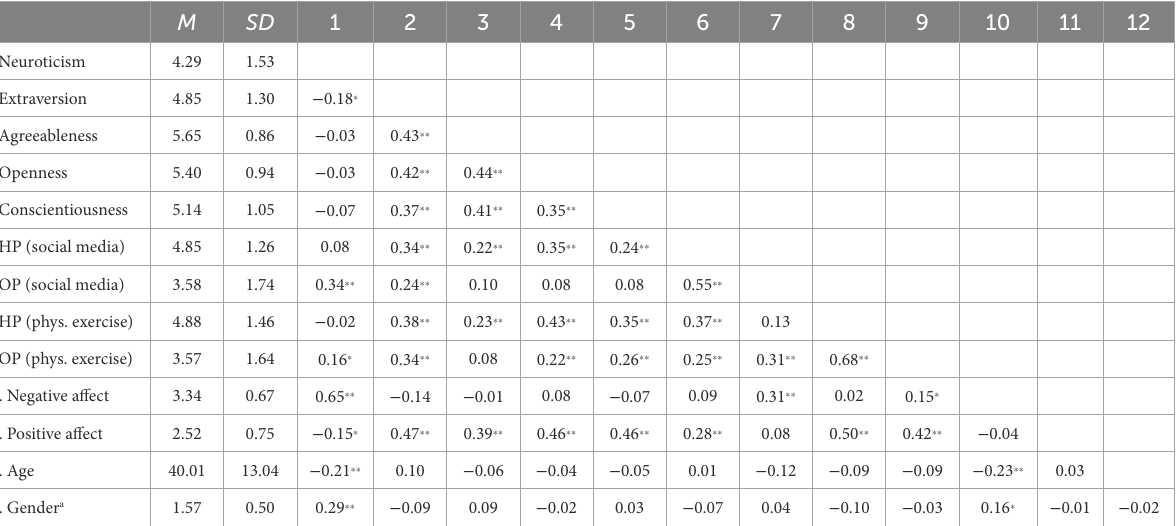
TABLE 2 Descriptive statistics and correlations ( N =